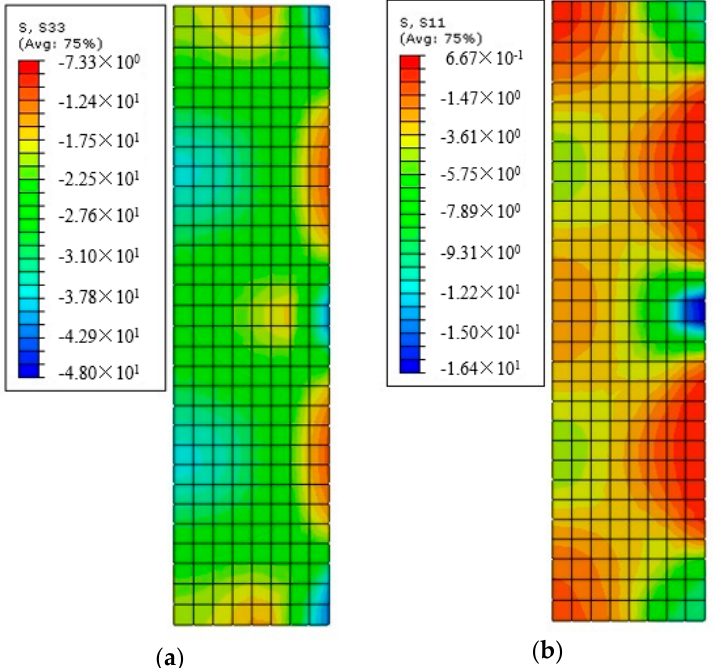
Figure 17. Stress distribution in shaft section ( X - Z section) of S-2-3-30 ( ε h,frp = 1.5%). ( a ) Axial stress; ( b ) Radial stress.